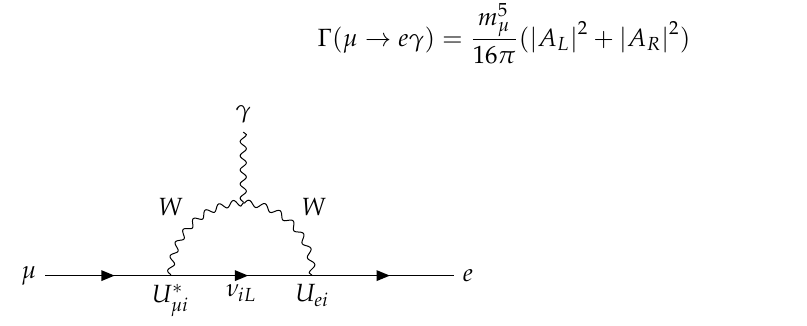
Figure 1. µ → e γ mediated by massive neutrinos ν iL